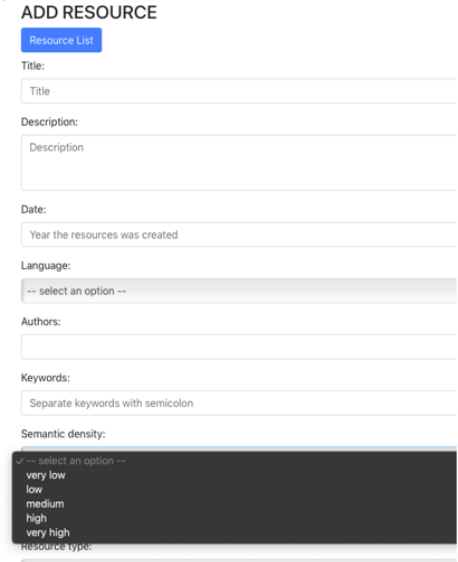
Figure 3. Part of the form that needs to be completed to add a new resource